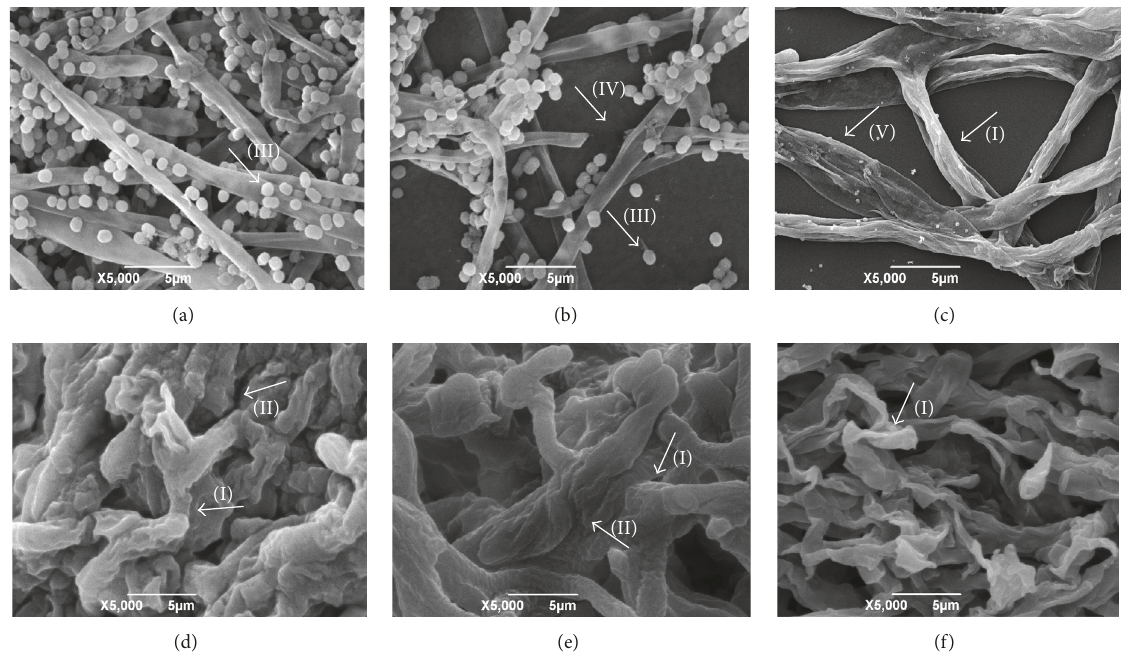
Figure4:Electronmicrographsof T.rubrum CCT5507URM1666exposedornottothereferencedrugsandhexahydropyrimidinederivative of interest. (a) T. rubrum CCT 5507 URM 1666 not subjected to pharmacological treatment; (b) T. rubrum CCT 5507 URM 1666 subjected to treatment with terbinafine; (c) T. rubrum CCT 5507 URM 1666 subjected to treatment with ketoconazole; (d) T. rubrum CCT 5507 URM 1666 subjected to treatment with HHP1; (e) T. rubrum CCT 5507 URM 1666 subjected to treatment with HHP3; (f) T. rubrum CCT 5507 URM 1666 subjected to treatment with HHP4. (I) Wrinkled hyphae. (II) crushed hyphae. (III) microconidia. (IV) hyphal breaks. (V) loss of hyphae intracellular